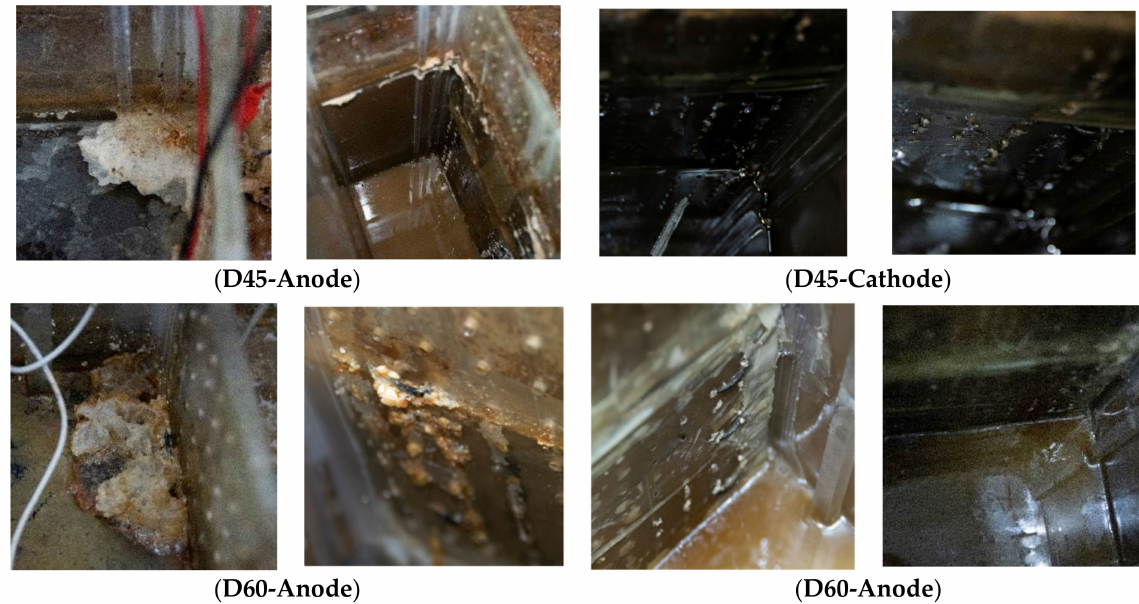
Figure 8. The clogging because of the anode’s perforated wall calcium carbonate (CaCO 3 ) precipitation for the two treated distances at 450 mm (D45) and 600 mm (D60) in the tests.